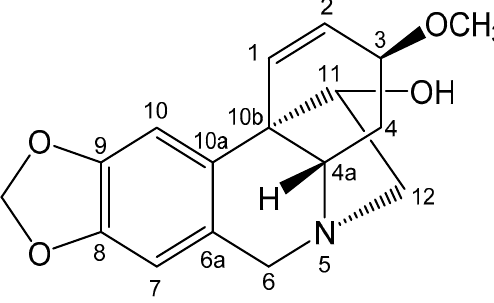
Figure 3. Chemical structure (NMR) of HAE.